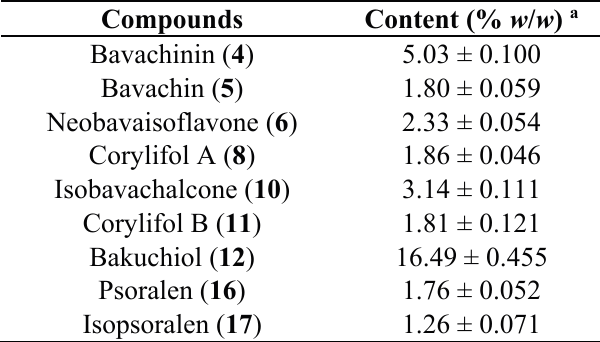
Table 3. Contents of major constituents in P. corylifolia EtOAc extract.